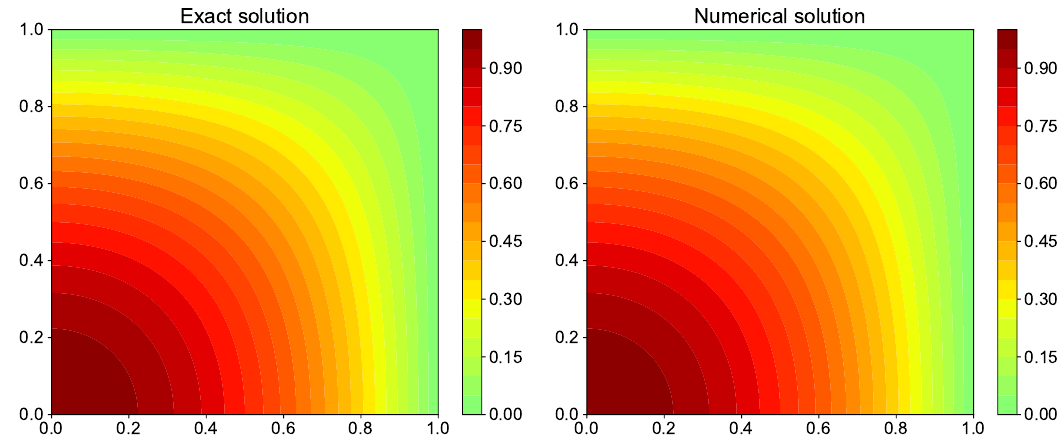
Figure 23. Comparison of exact solution and numerical solution computed using multigrid framework for the Poisson equation.